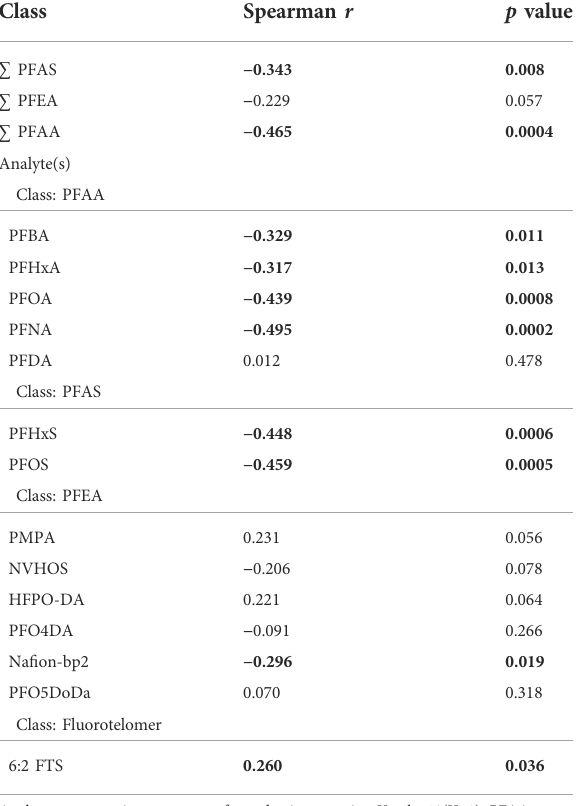
TABLE 2 Correlation of PFAS concentrations and distance from Fayetteville Works production